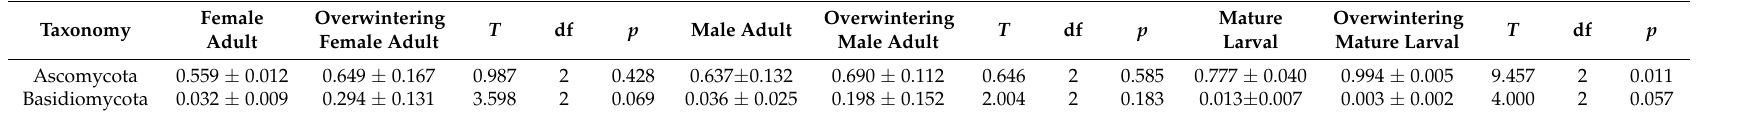
Table A2. The relative abundance of the different fungal taxa in different generations of T. klimeschi at the phylum level.